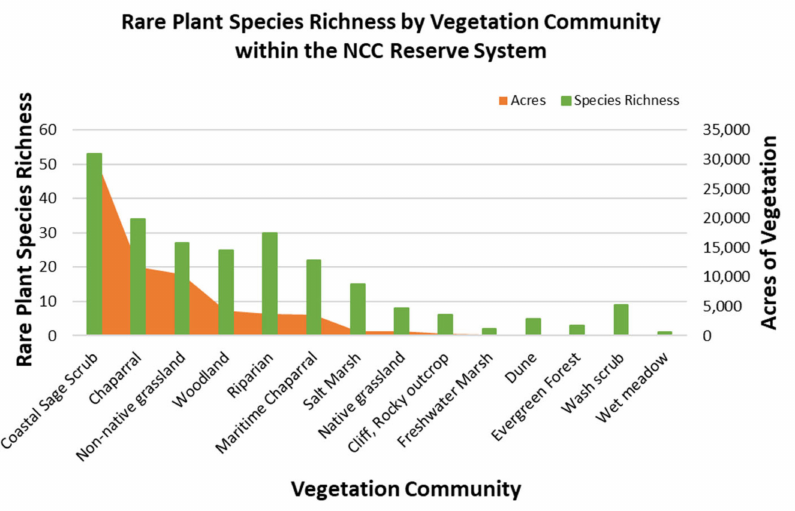
Figure 4. Rare plant species richness within each vegetation community with acres of each vegetation type within the Natural Communities Coalition Reserve System. Coastal sage scrub has the highest acreage and the highest rare plant species richness of